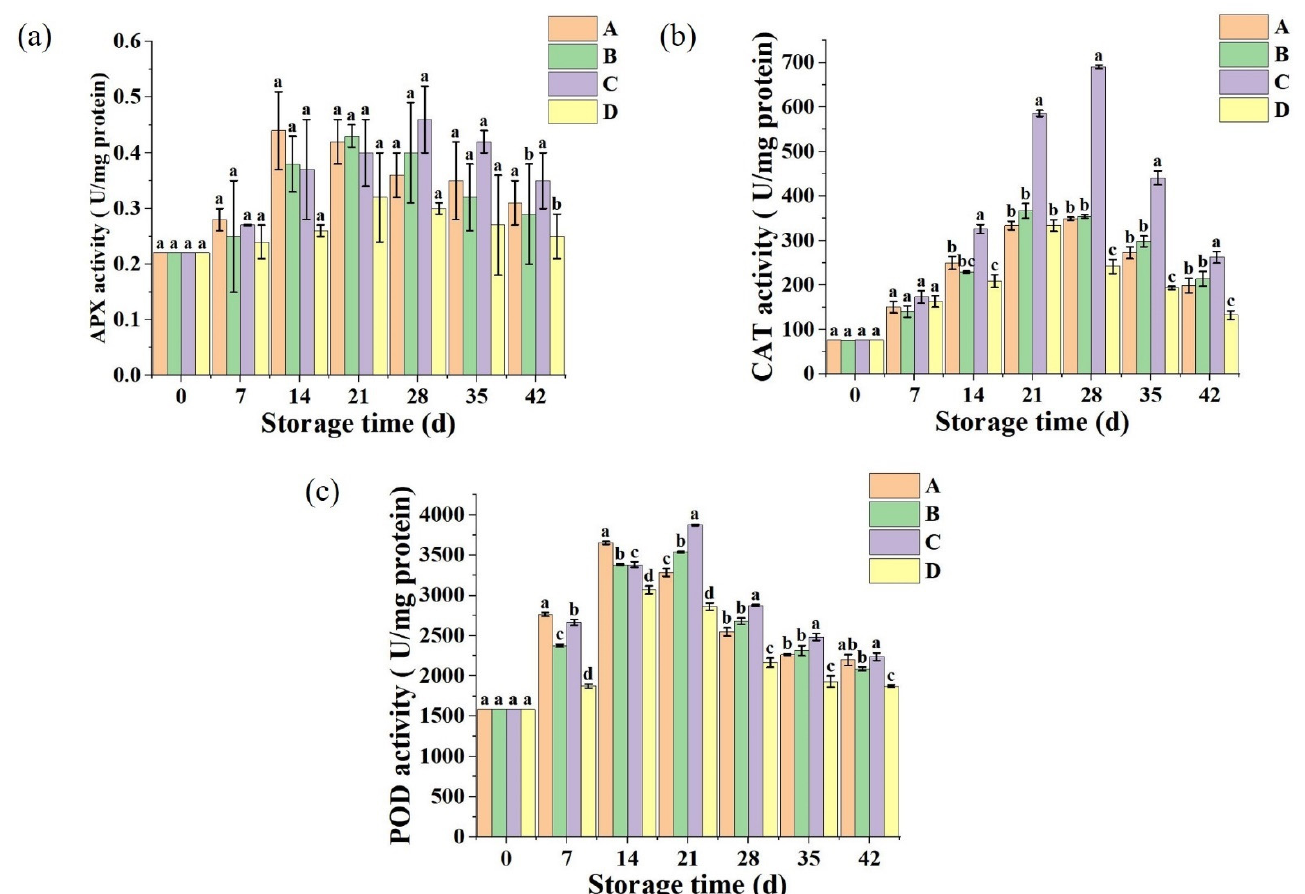
Figure 4. Treatment changes of APX ( a ), CAT ( b ), and POD ( c ) activities of sweet corn by different freezing methods. Values with different lowercase letters in the same sampling are significantly different ( p < 0.05). (A: Ultrasound ‐ assisted freezing, B: Brine freezing, C: Strong wind freezing, D: Refrigerator freezing).